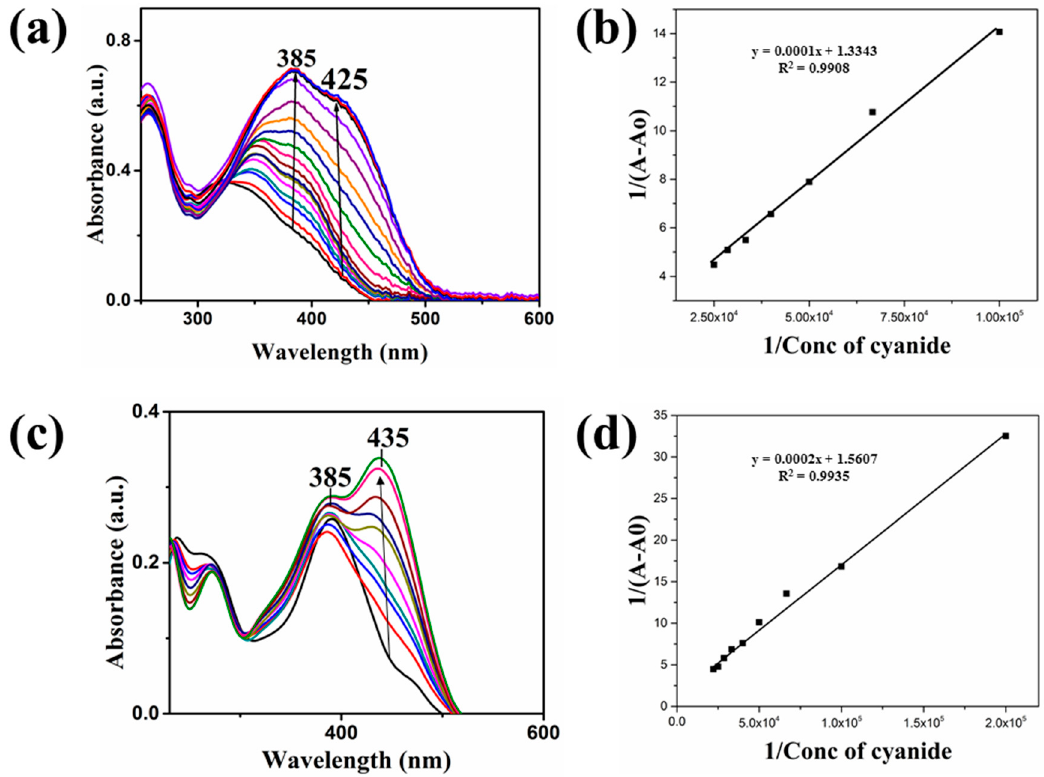
Figure 5. ( a , c ) Sensors 1 and 2 titrations with cyanide from 5 × 10 − 6 M to 8 × 10 − 5 M and from 5 × 10 − 6 to 5 × 10 − 5 M, respectively; ( b , d ) Benesi–Hildebrand plots of the reaction of 1 and 2 respectively with cyanide.